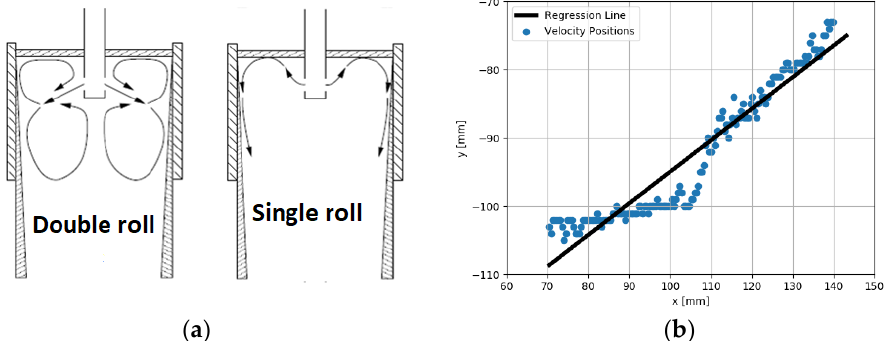
Figure 1. ( a ) Flow patterns in the mold; ( b ) parametrization of the jet flow using a line with a variable angle.